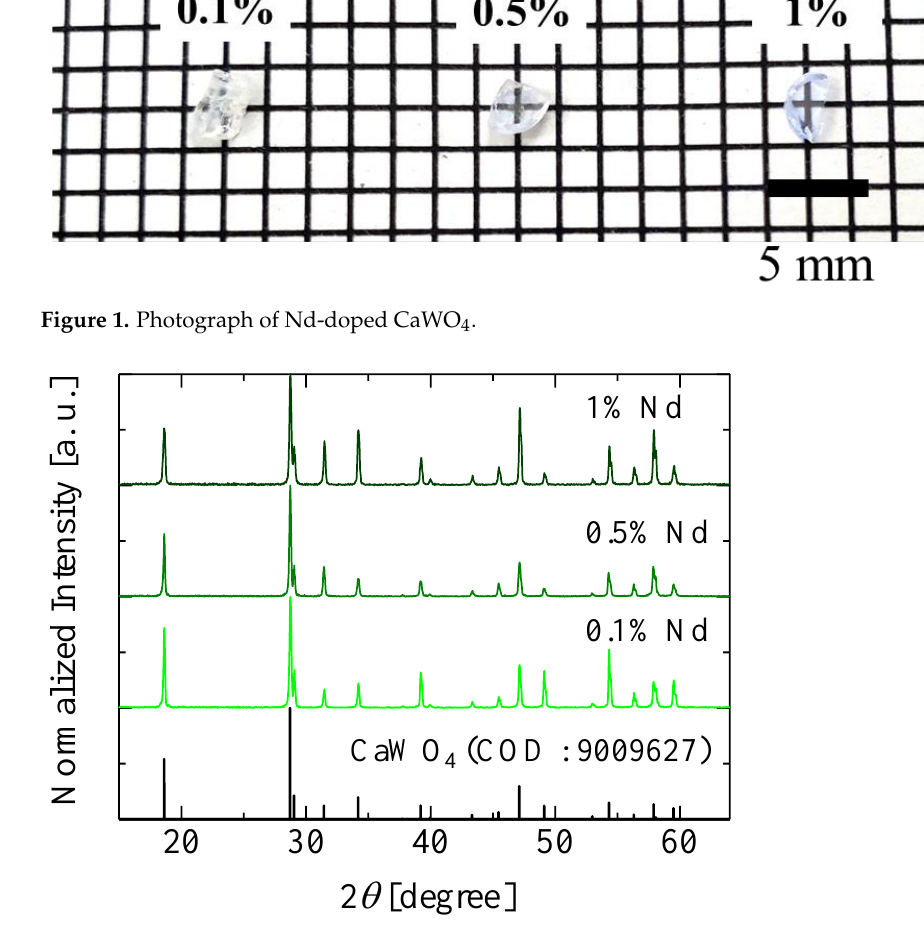
Figure 1. Photograph of Nd-doped CaWO 4 .